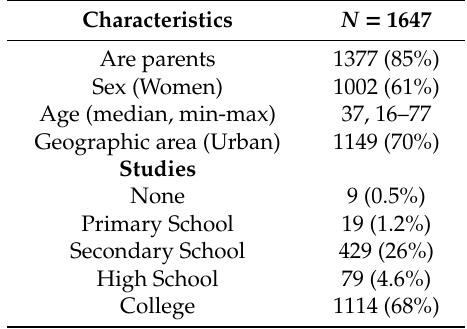
Table 1. Sociodemographic and educational characteristics of respondents to the